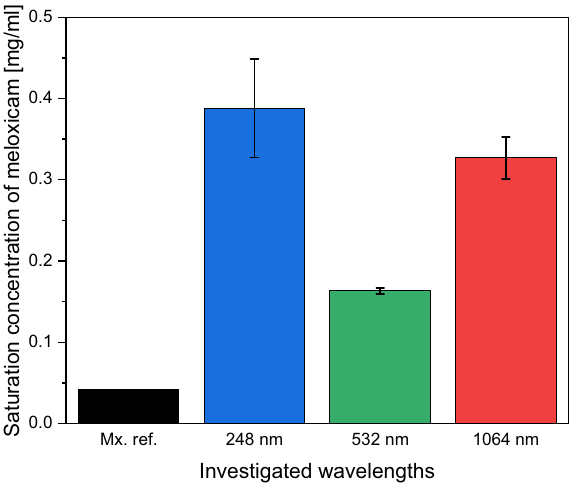
Figure 14. Solubility data of the commercially available meloxicam (Mx. ref.) and the samples produced with different ablation wavelengths (248 nm, 532 nm, 1064 nm).